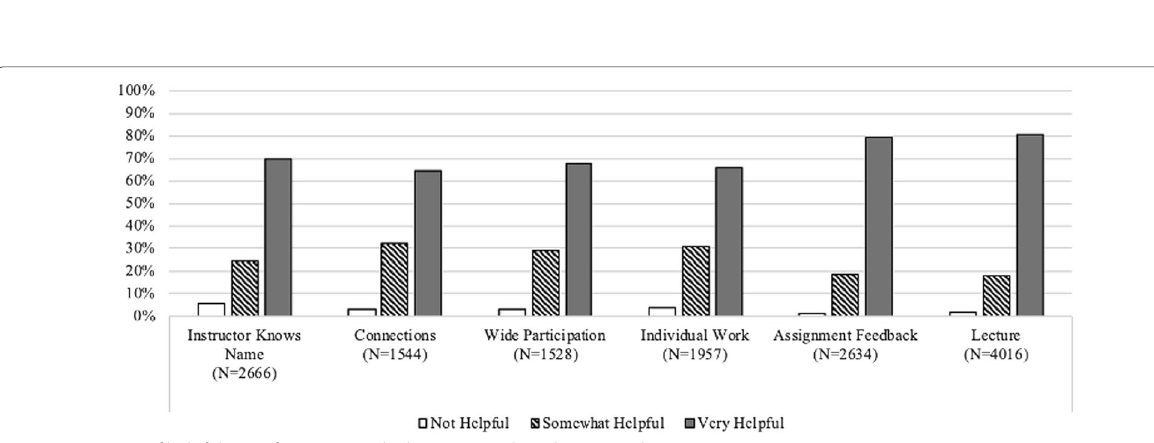
Fig. 7 Summary of helpfulness of very or mostly descriptive Other Classroom